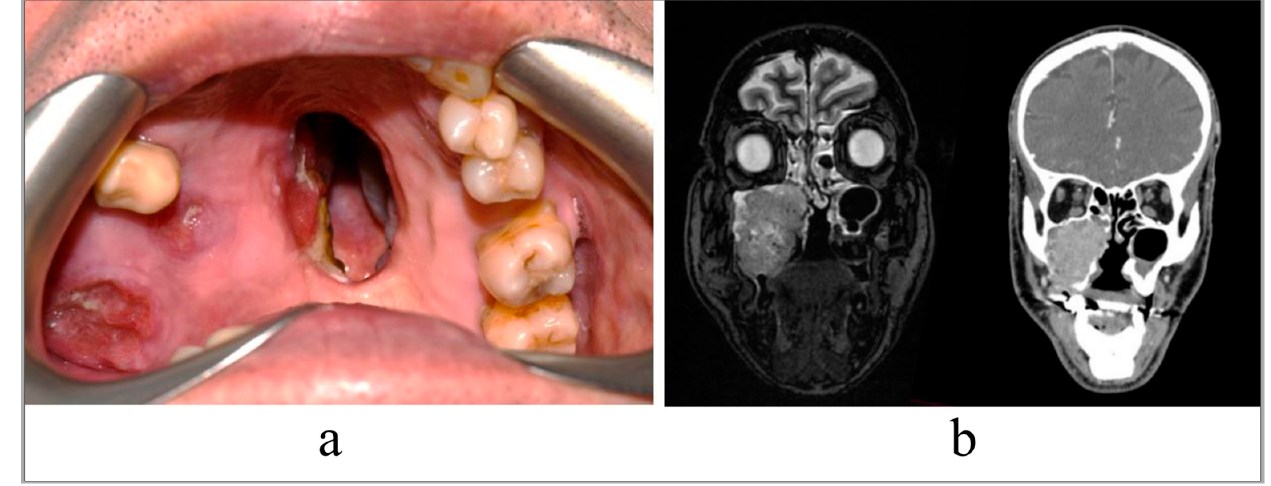
Figure 1. ( a ) Intraoral view of the tumor; ( b ) preoperative RMN and CT scan, coronal